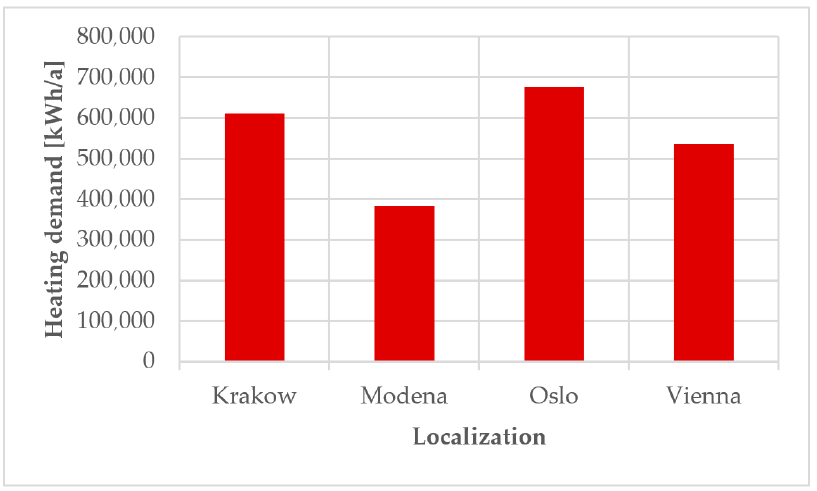
Figure 12. Energy demand for heating depending on building location.